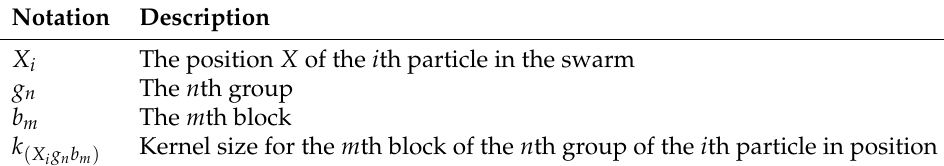
Table 2. A summary of the